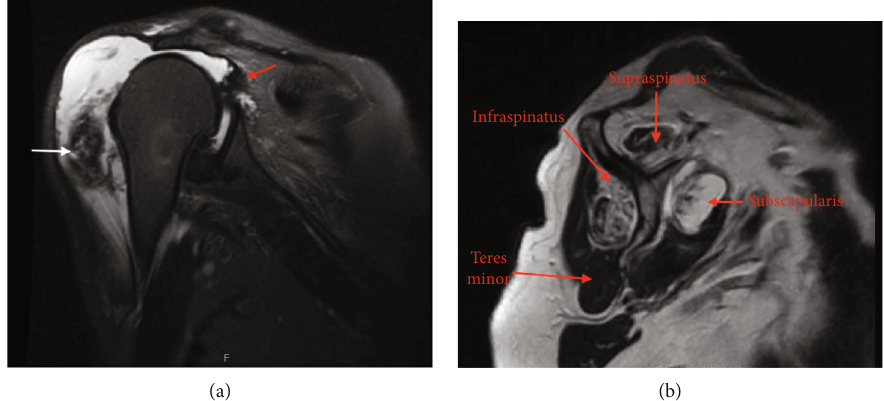
Figure 3: Coronal (a) and sagittal (b) view of a T2-weighted MRI of the right shoulder showing a large e ff usion with rupture of the deltoid (white arrow) and rotator cu ff tear (red arrow).